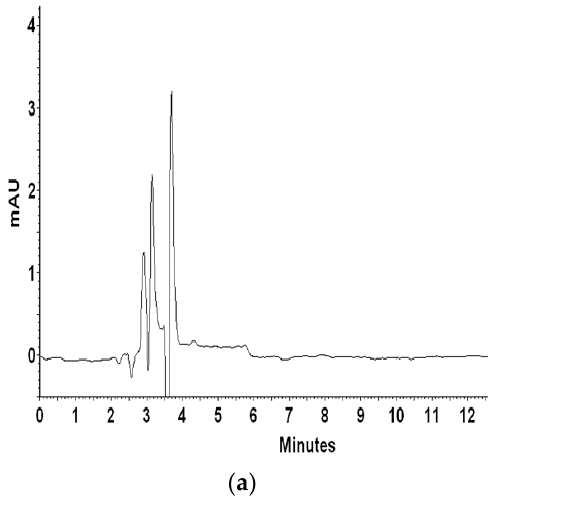
Table 1. The statistical parameters of the calibration curves (y = ax + b).